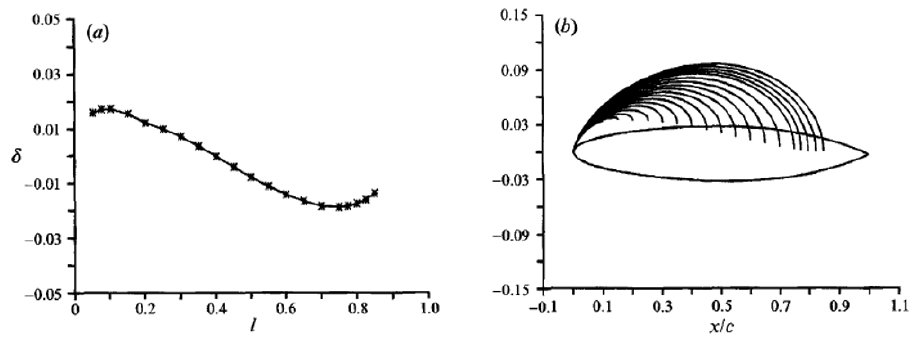
Figure 4. NACA16006 hydrofoil at α = 4 ◦ and σ = 1.097 (corresponding to the correct length l = 0.4). ( a ) The resulting behavior of δ vs. l ; ( b ) The predicted cavity shapes in ratio of blade radius ( y -axis) for different guesses of l , obtained from Figure 4 of [22], with permission from the prime author, Spyros A. Kinnas in